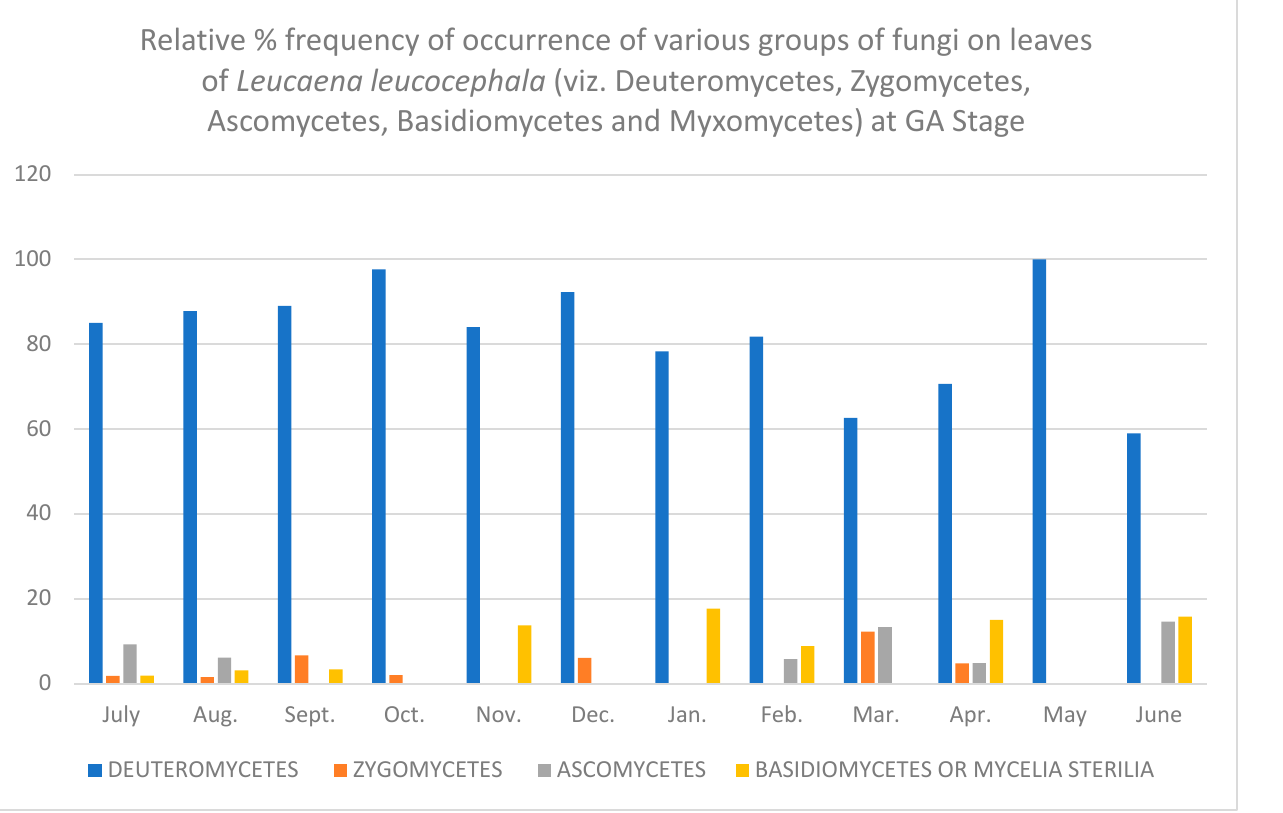
Figure 1. Relative % frequency of occurrence of various groups of fungi on leaves of Leucaena leucocephala (viz. Deuteromycetes, Zygomycetes, Ascomycetes, Basidiomycetes and Myxomycetes) at GA Stage.